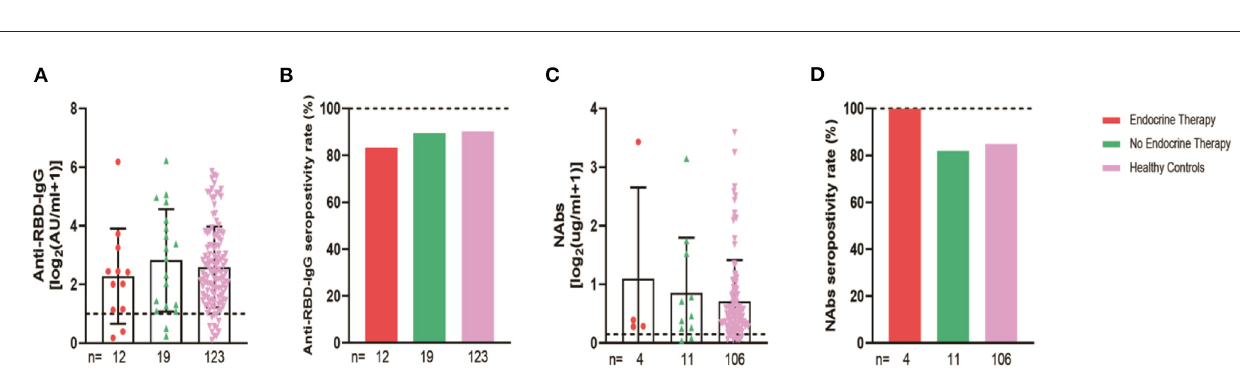
FIGURE9 Antibody response to SARS-CoV-2 vaccine in breast cancer patients with or without Endocrine Therapy. Subgroup analysis of the titers and seropositivity rate of anti-receptor binding domain (RBD)-IgG (A, B) and NAbs (C, D) in participants according to different treatments. The horizontal dotted lines represent the limit of detection. The error bars represent the median (IQR). NAbs, neutralizing antibodies; IQR, interquartile range; RBD, receptor binding domain.